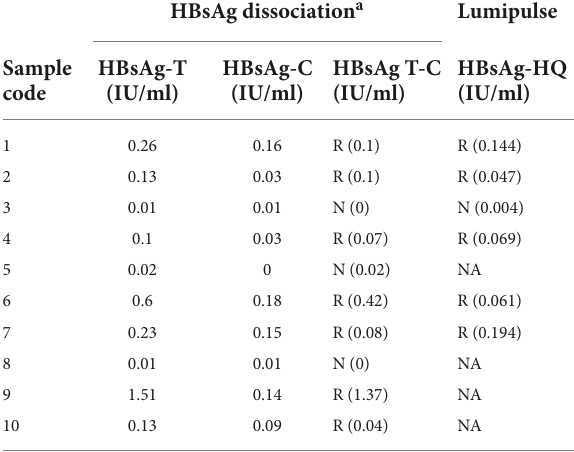
TABLE 2 HBsAg-CICs detection of the 10 HBsAg-/anti-HBs+/HBeAg+ samples. HBsAg dissociation a Lumipulse